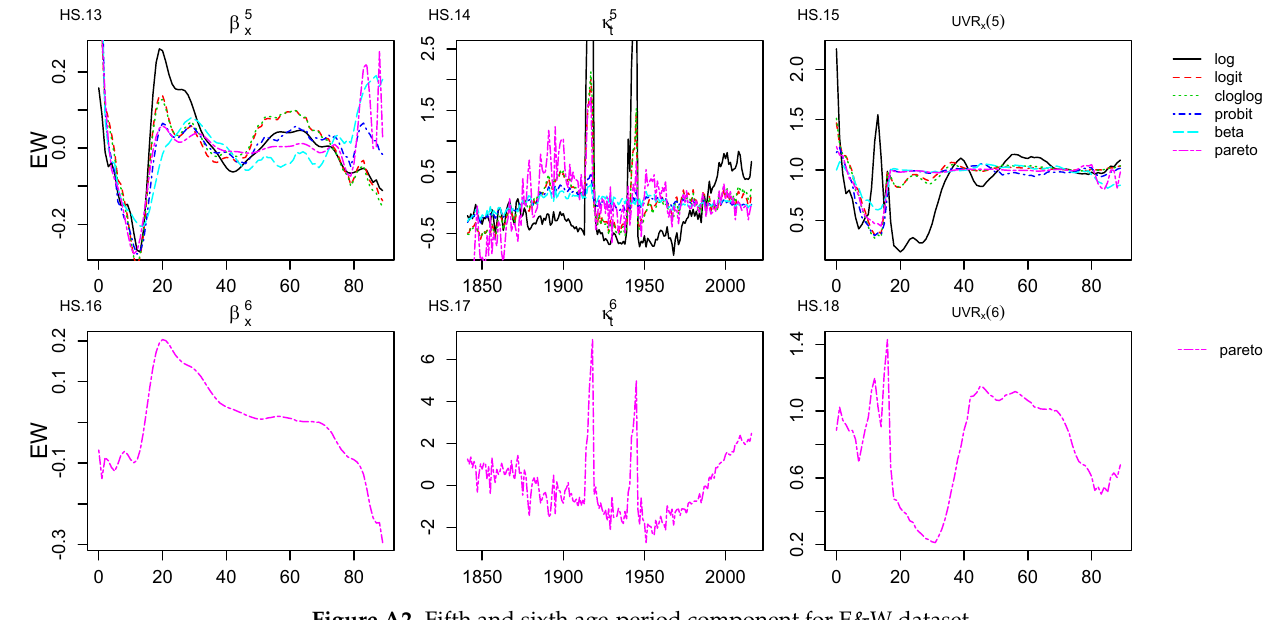
Figure A2. Fifth and sixth age-period component for E&W dataset.